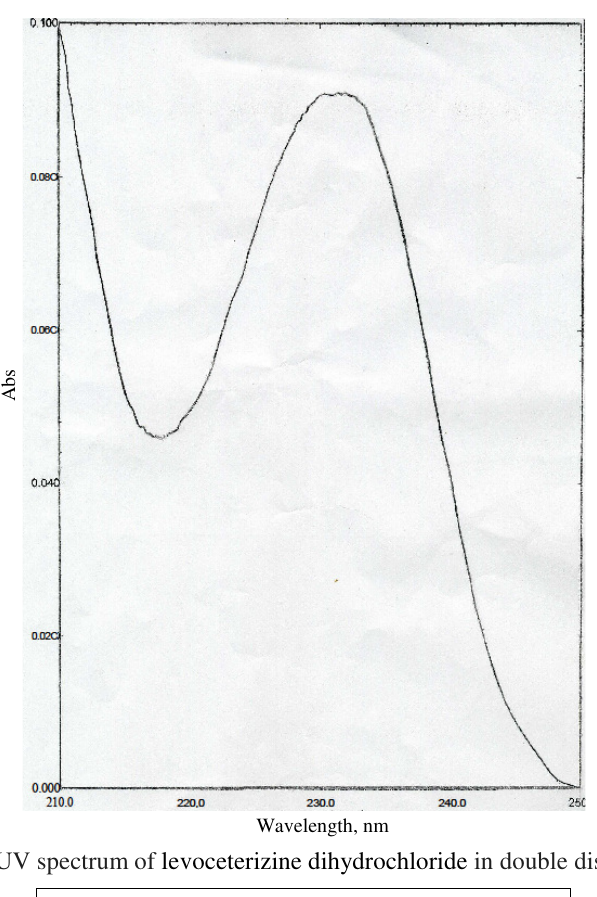
Figure 2 . UV spectrum of levoceterizine dihydrochloride in double distilled water Standard graph